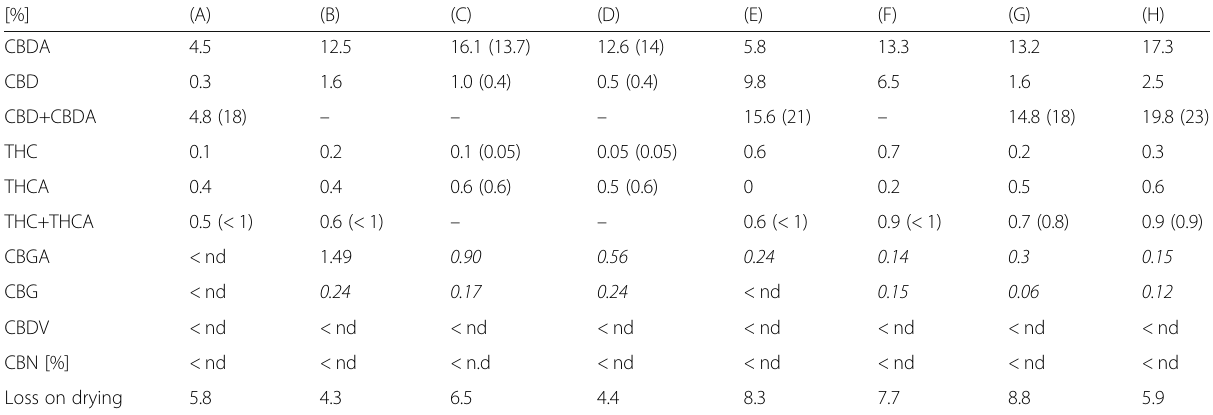
Table 3 Content of cannabinoids in commercial available hemp samples. Declared values were given in parenthesis. Values written in italics are below the